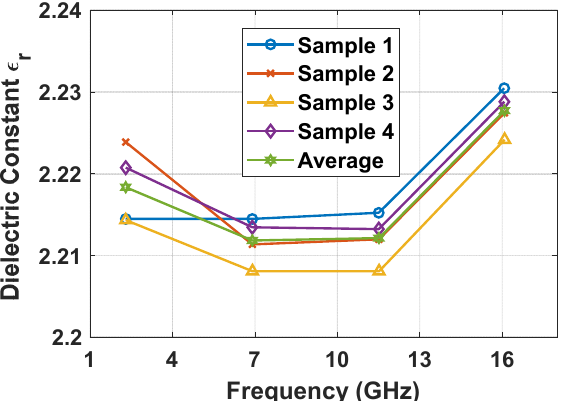
Figure 4. The extracted dielectric constant values of the Taconic TLY samples. By applying Equations (14) and (15) described in Section 2.2, the loaded ( Q L ) and unloaded ( Q 0 ) quality factors of the four samples at different resonant frequencies can be calculated, which are shown in Figure 5a,b, respectively. As can be seen from the figure, the average values of Q L and Q 0 at resonance order 1 ( ∼ 2.3 GHz), order 3 ( ∼ 6.9 GHz), order 5 ( ∼ 11.5 GHz), and order 7 ( ∼ 16.1 GHz) are 209.1 and 211.3, 193.5 and 206.9, 188.7 and 212.1, and 125.4 and 155.5, respectively. The Q 0 of the UGPCW embedded resonator at order 1 reaches 211.3, which is higher than those of microstrip line-based quarter-wave stub resonators, half-wave line resonators, and ring resonators in the literature [8,13,19,20]. For the proposed UGCPW embedded resonator, high current density is mainly concentrated on the line edges, and the current located in the central embedded resonator stub is small, which helps to achieve the high Q value.